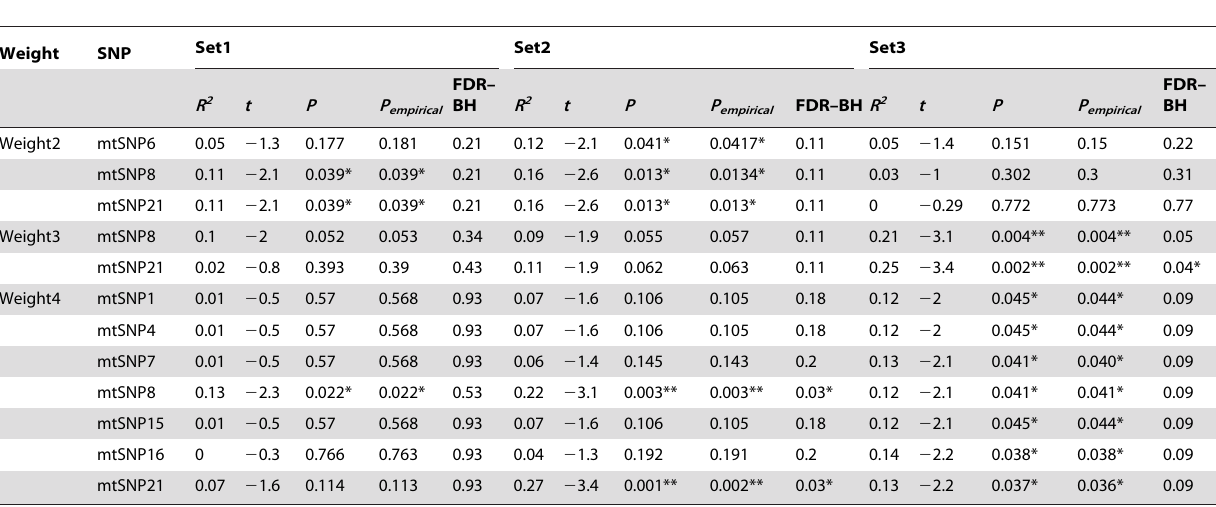
Table 5. Association of mitochondrial SNPs with weight 1 using population-based association analysis 2 .